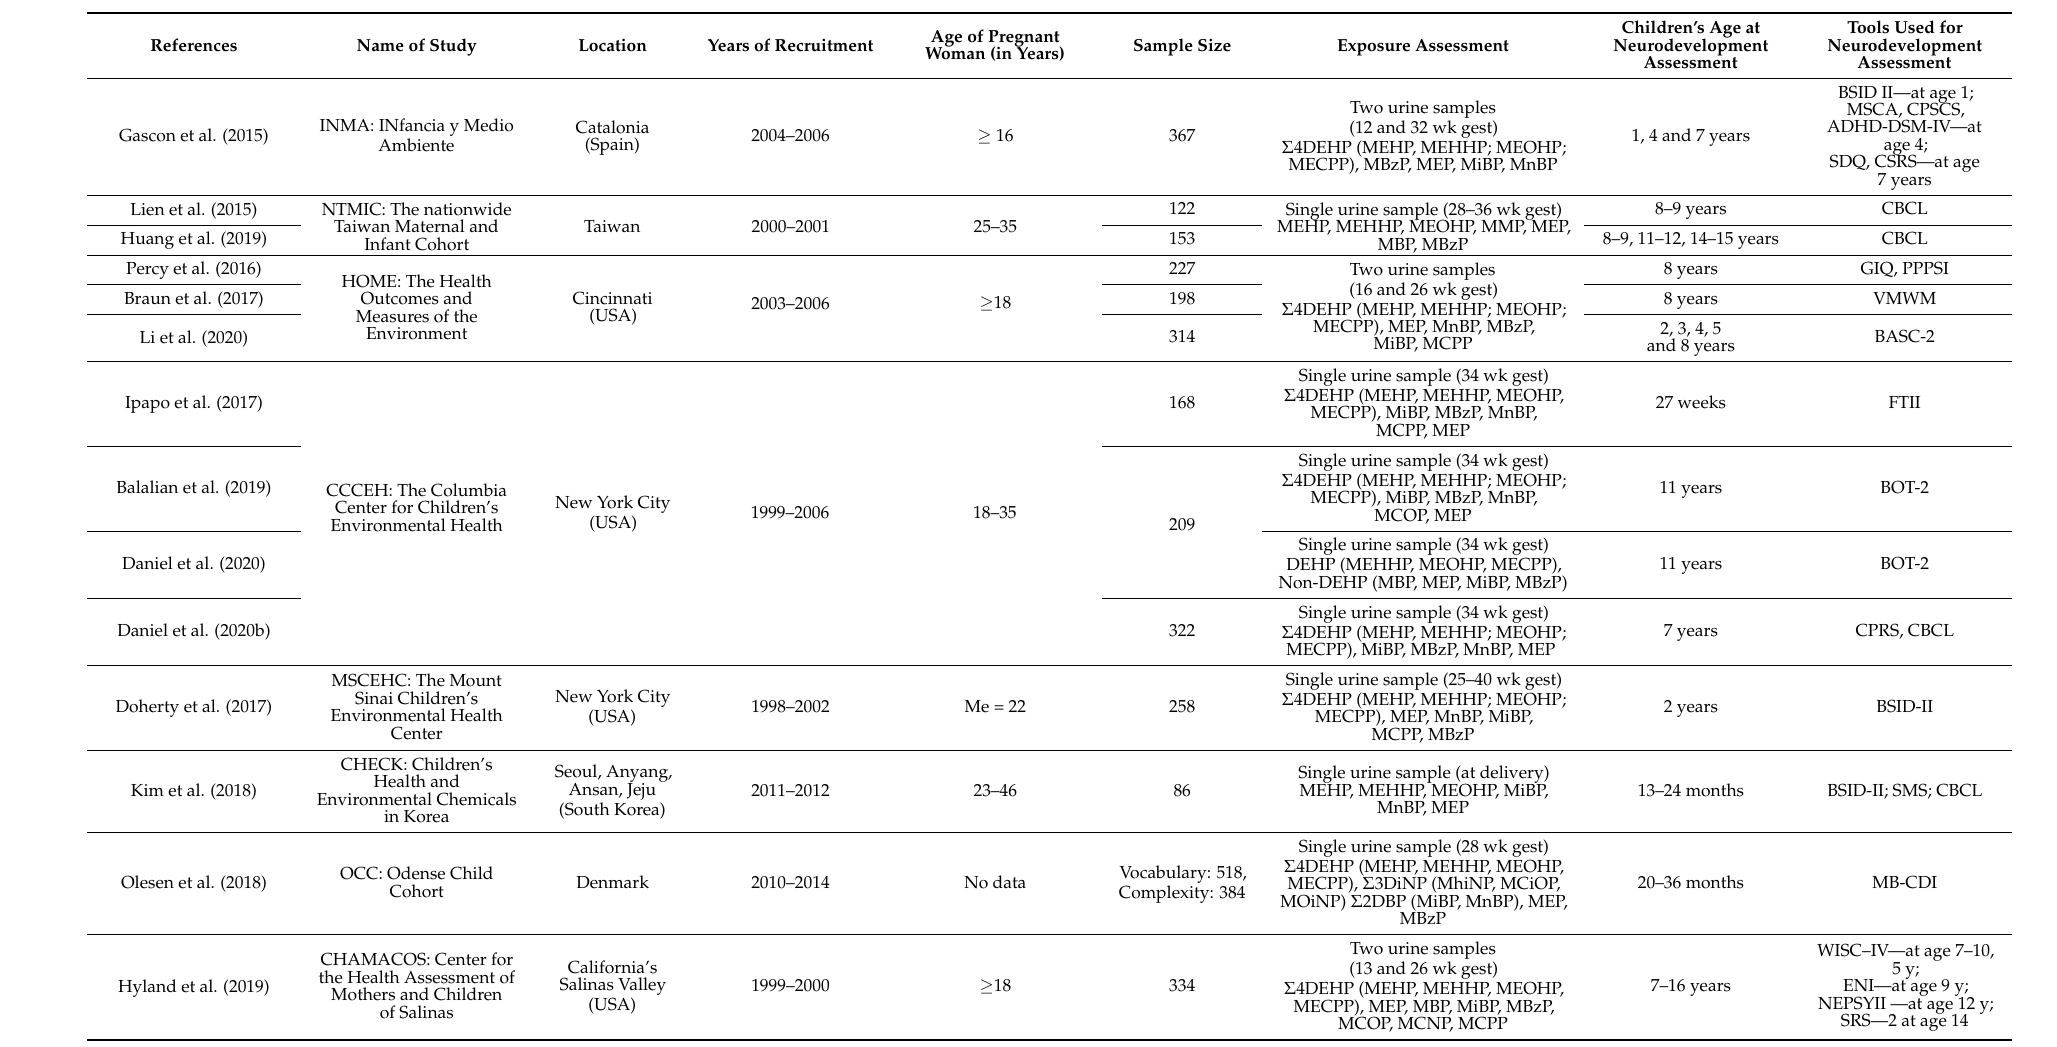
Table 1. Characteristics of studies included in the systematic